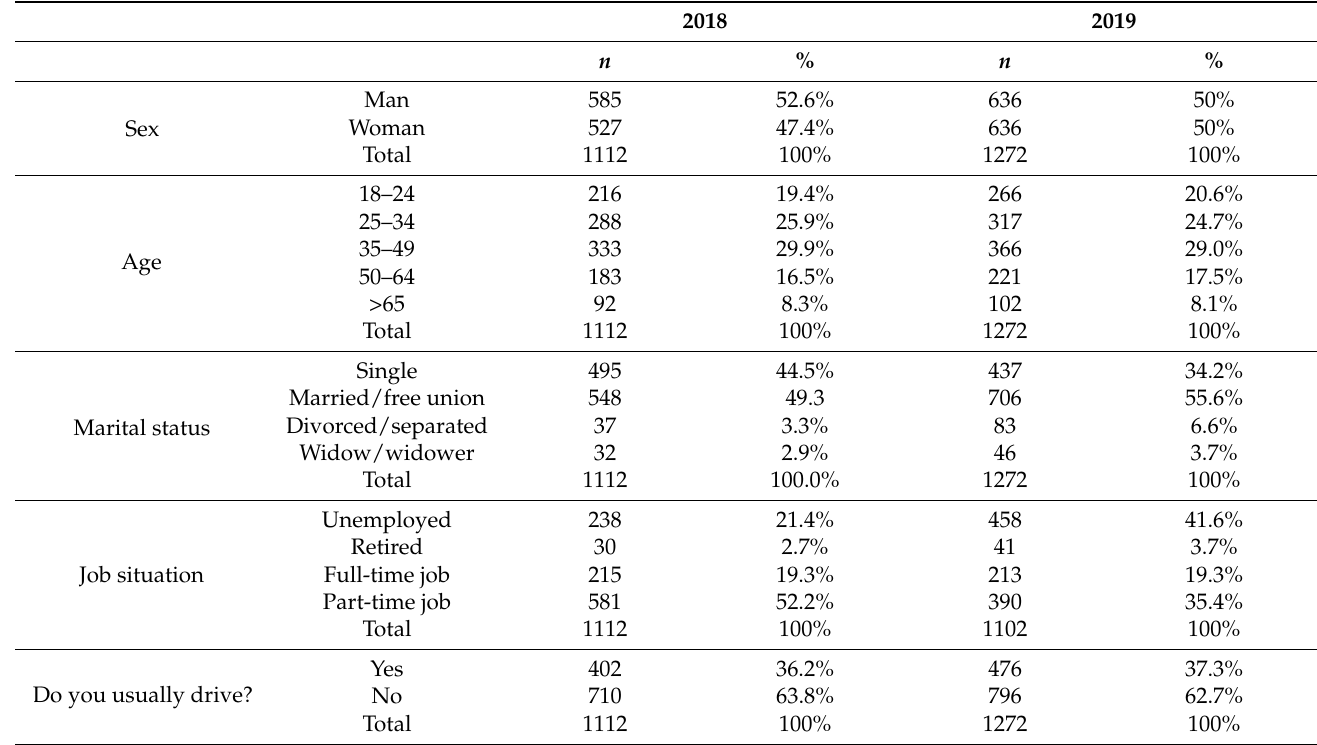
Table 1. Sociodemographic